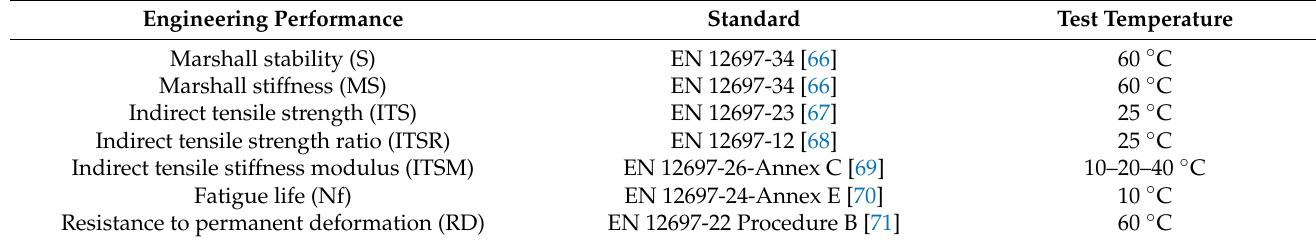
Table 1. Engineering performance of asphalt